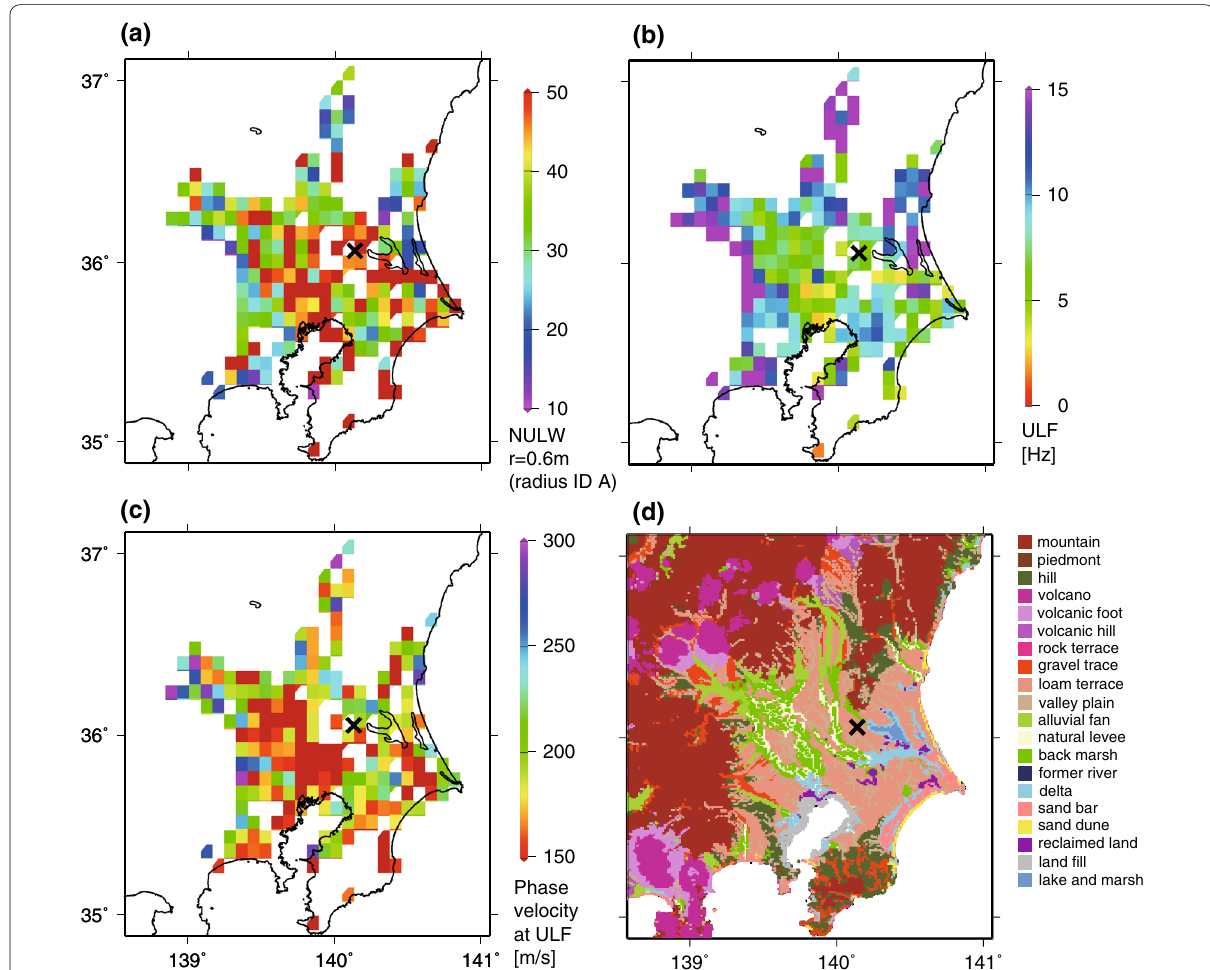
Fig. 14 a Spatial distribution of the NULWs for the radius ID A in Fig. 11 compared with the distributions of b the corresponding ULFs, c phase velocities at the ULFs, and d geomorphologic classifications of Wakamatsu et al. (2005). The location of Tsukuba city, related to Figs. 10 and 13, is plotted with a cross in each